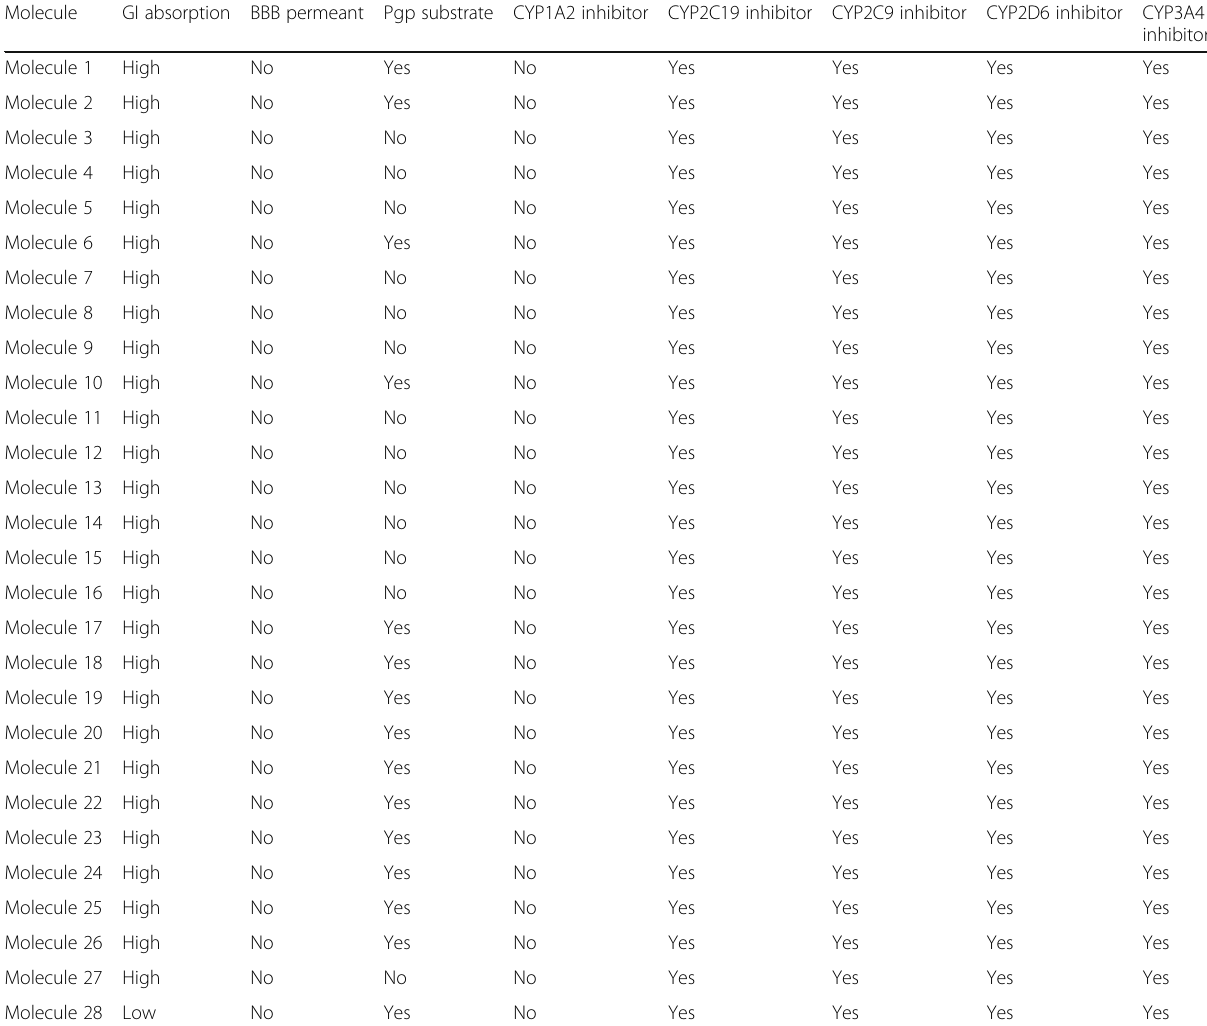
Table 4 Boiled-egg and CYP isoforms inhibition